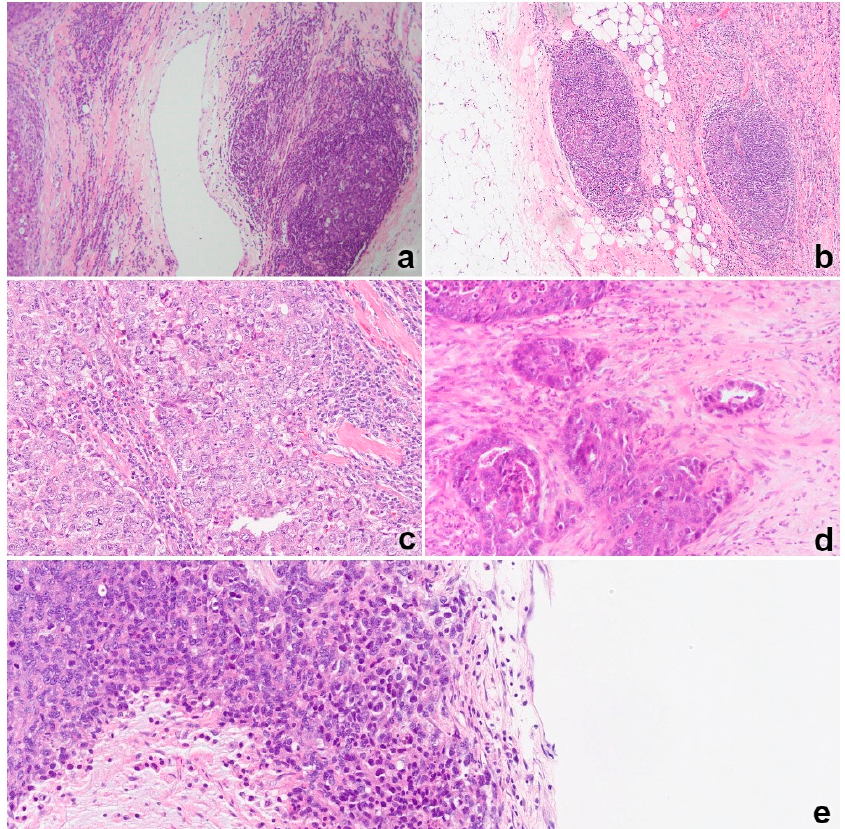
Figure 2. Tumor microenvironment: ( a ) secondary lymphoid aggregate with germinal center found on the invasive front of a tumor; ( b ) the primary lymphoid aggregate formation is easily discernible from the surrounding stromal TIL; ( c ) high stromal TILs occupying most of the stromal compartment on the periphery of the tumor (sTIL peripheral) and between islands of tumor cells (sTIL central); ( d ) low stromal TILs; ( e ) high intratumoral TILs defined as TIL in close contact with more than 10% of tumor